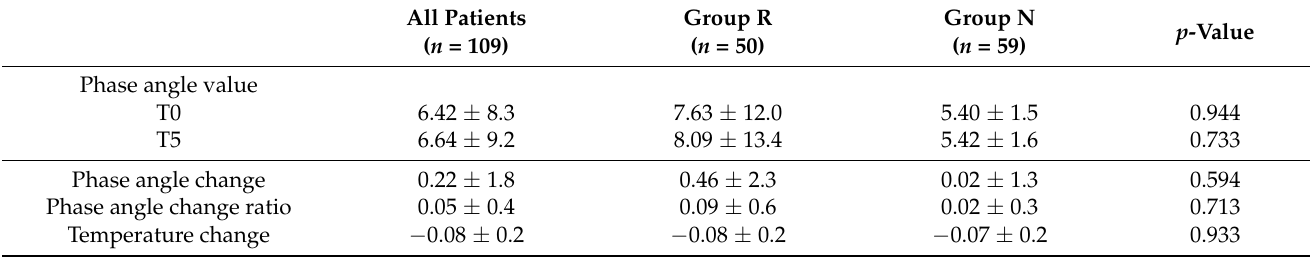
Table 2. Phase angle and temperature.